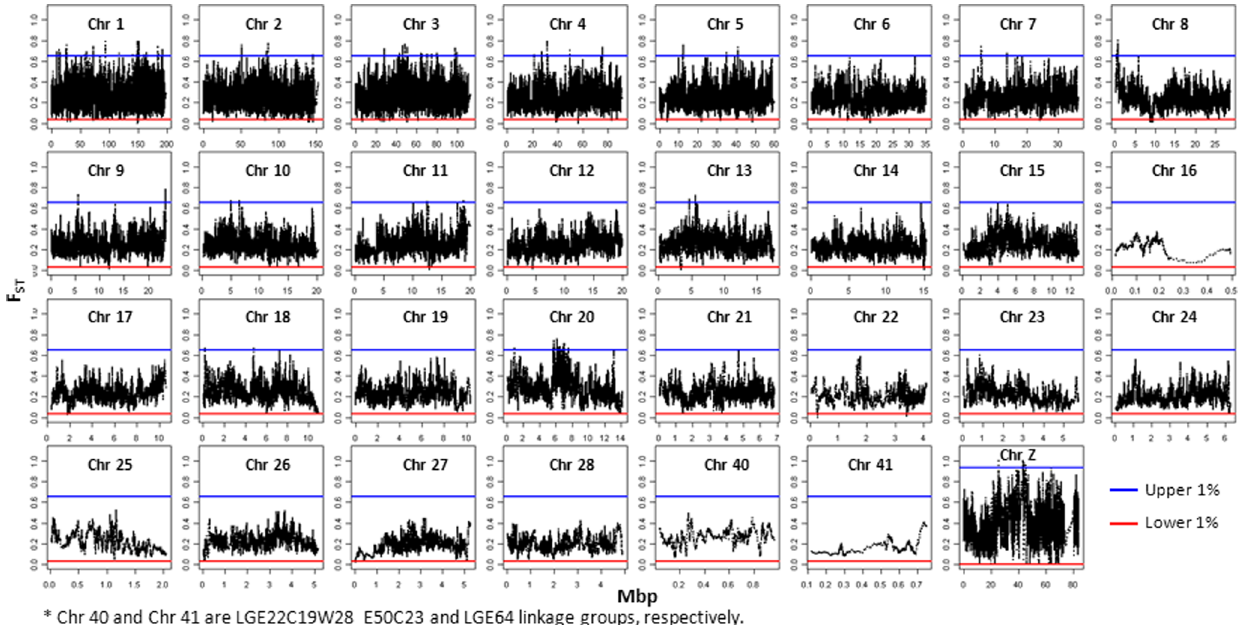
Figure 4. FST-values of overlapping windows for comparison between brown layers and white layers. Red (blue line) indicates the upper (lower) 1% of FST distribution.